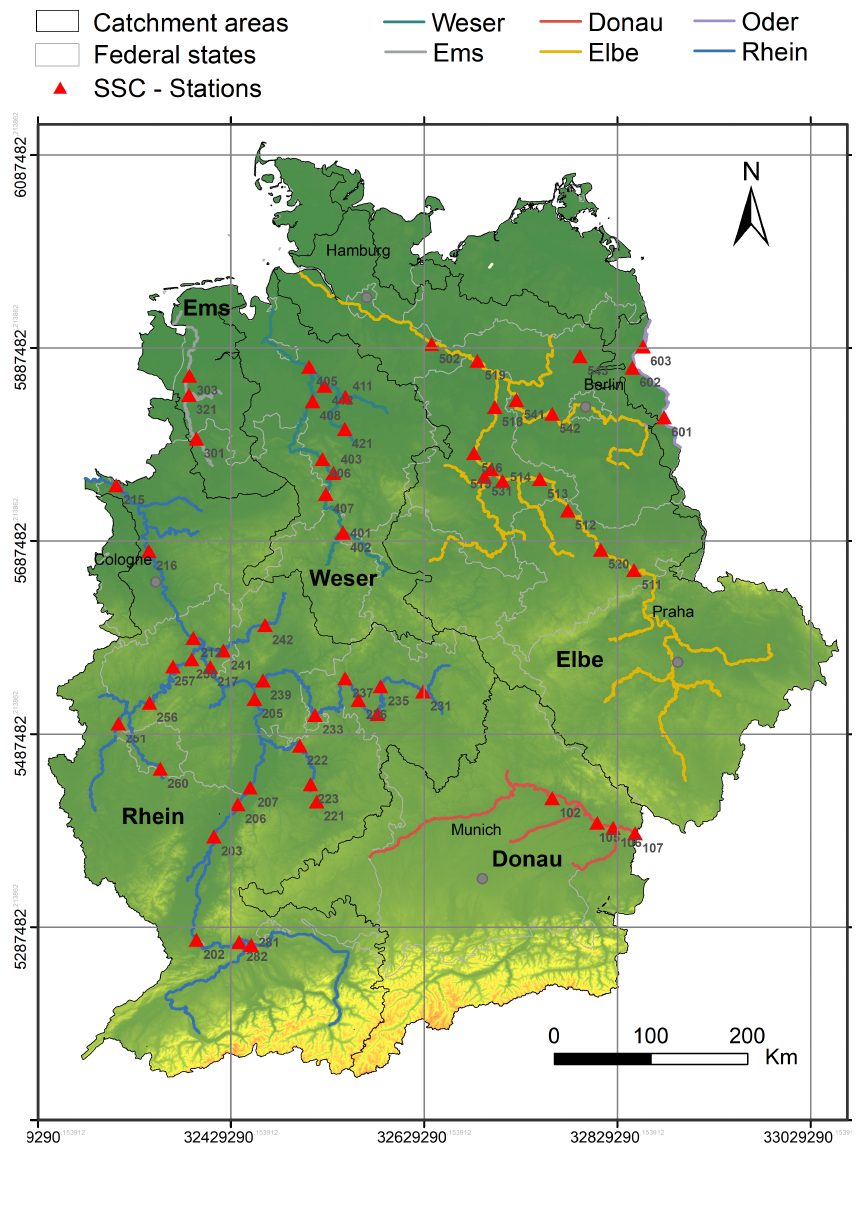
Figure 1. Spatial distribution of sampling stations, major river systems, and catchment boundaries in